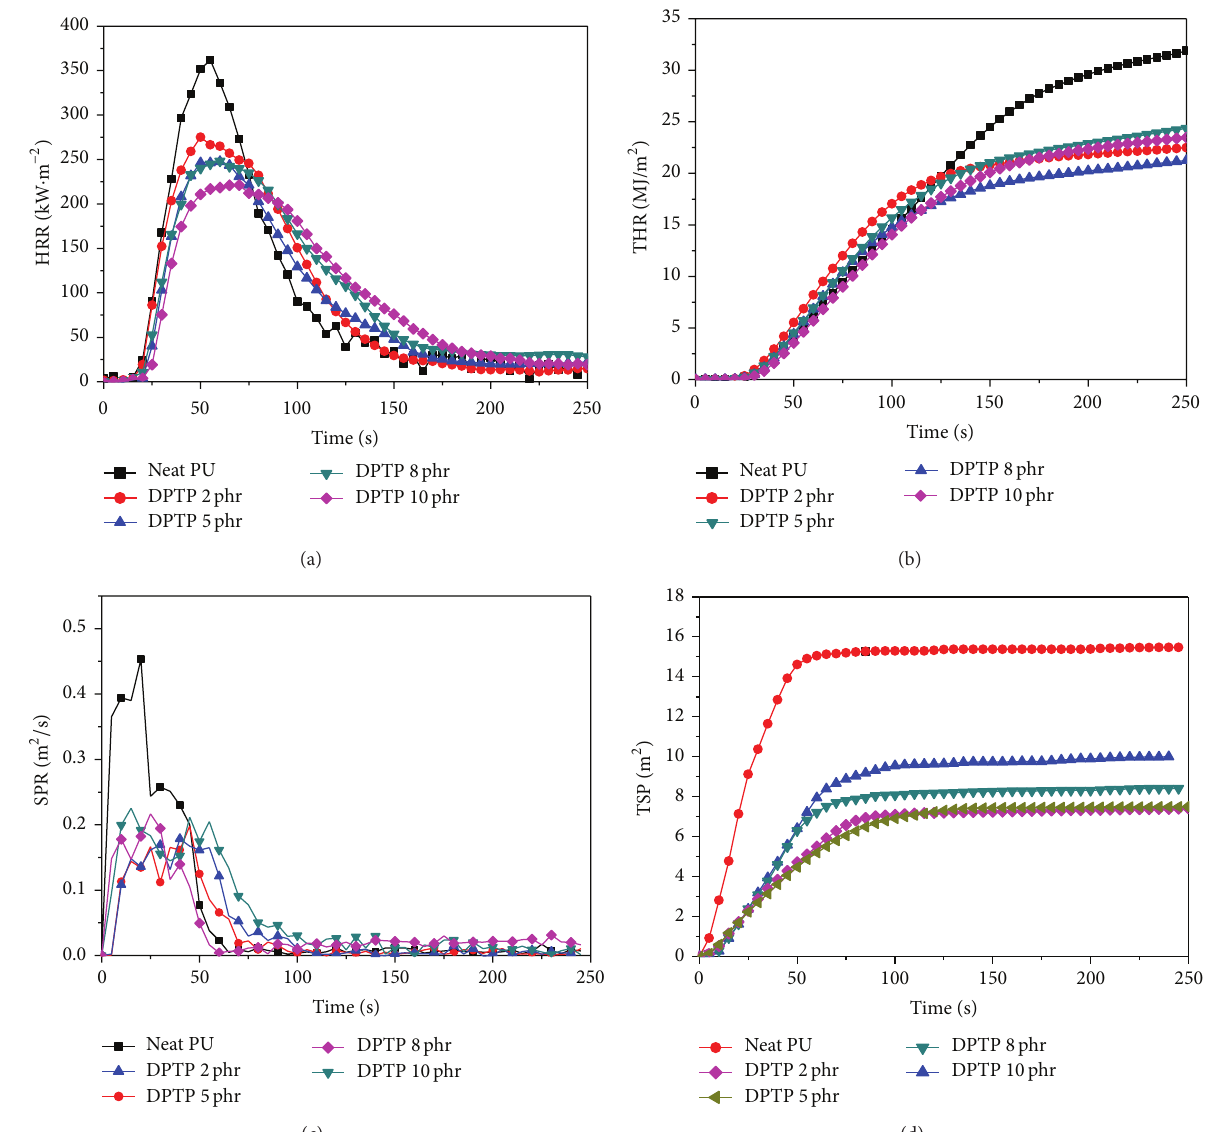
Figure 6: (a) Heat release rate of RPUF, (b) total heat release of RPUF, (c) smoke release rate of RPUF, and (d) total smoke release of RPUF.